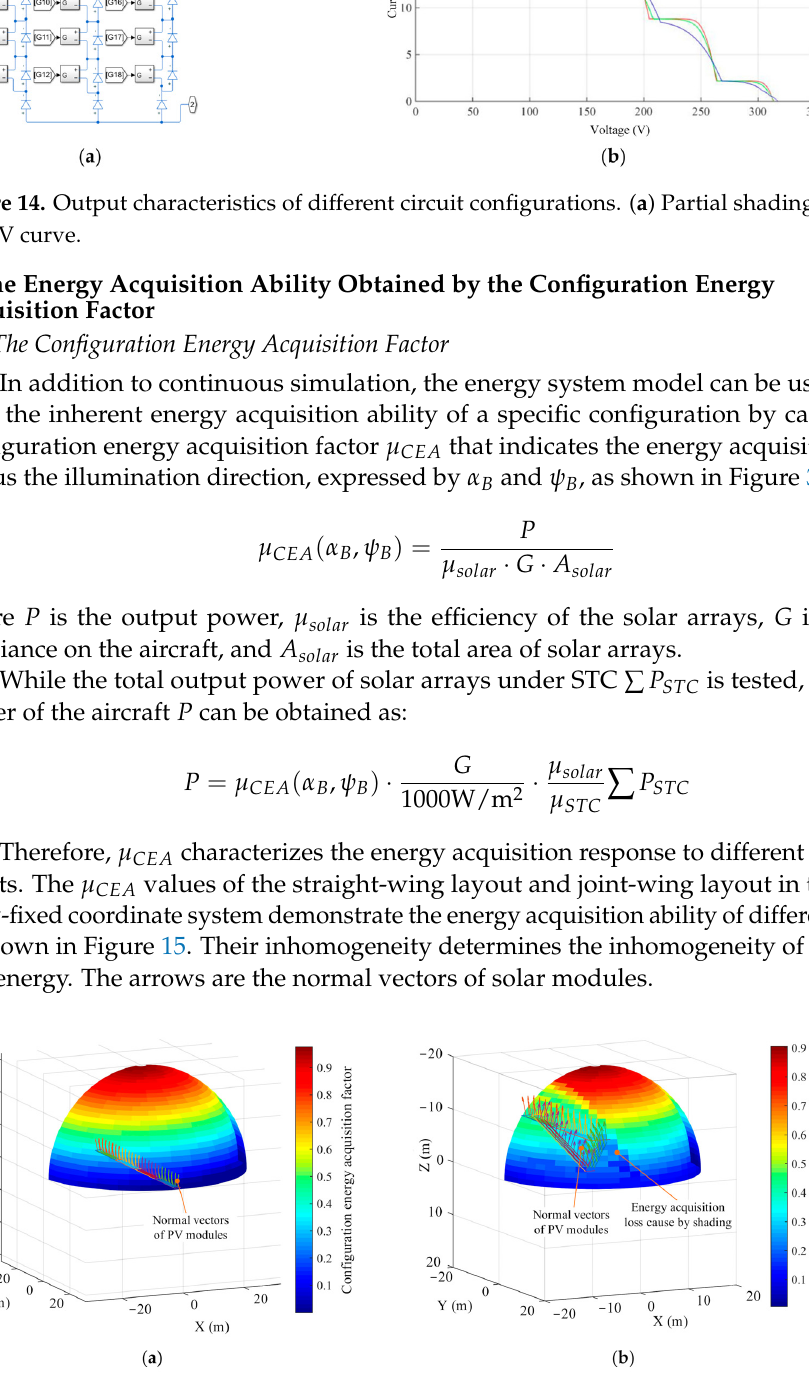
Figure 15. Energy acquisition ability in aircraft body-fixed coordinate system. ( a ) µ CEA of straight- wing layout. ( b ) µ CEA of joint-wing